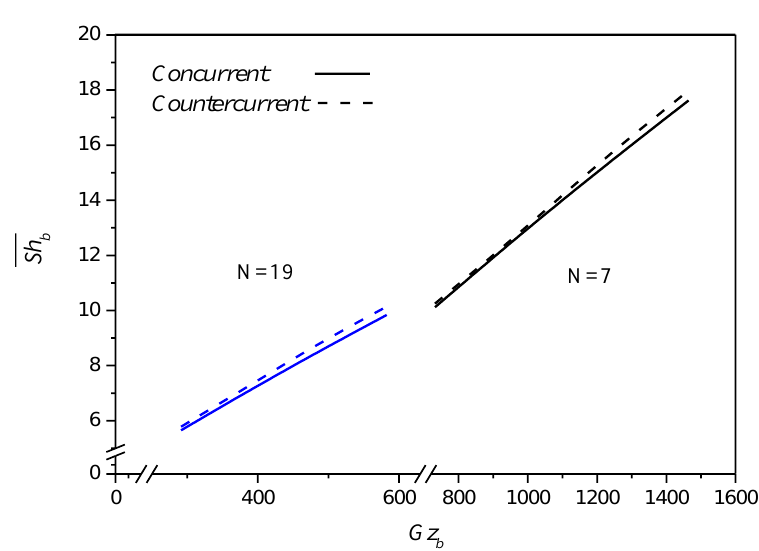
Figure 8. Effects of fiber number, flow pattern and 𝐺𝑧 𝑏 on theoretical averaged Sherwood number.